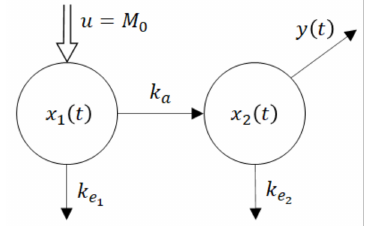
Figure 5. Two-compartment model of per-oral instantaneous